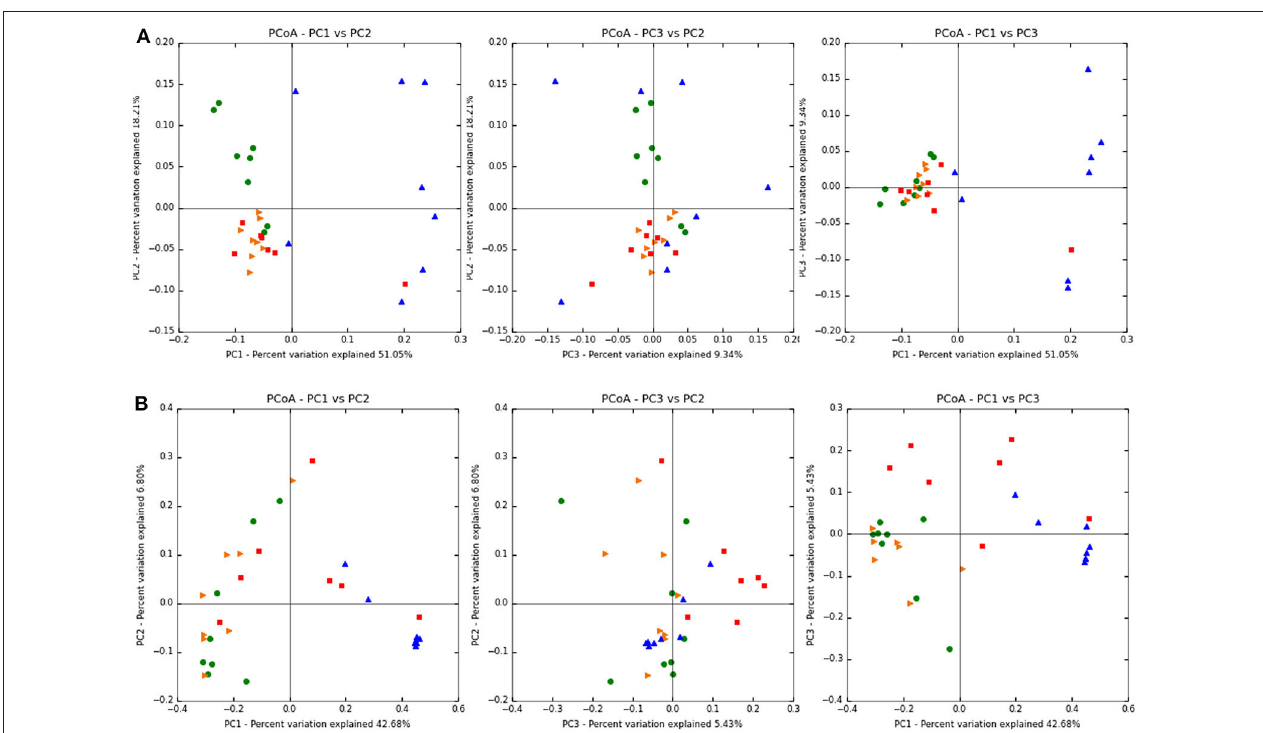
FIGURE 2 | Unifrac PcoA plots of the treatment groups. (A) Weighted (B) unweighted. Treatment groups include: BMD treated, cecum (red squares); BMD treated, distal colon (blue triangles); Control, cecum (orange triangles); Control, distal colon (green circles).